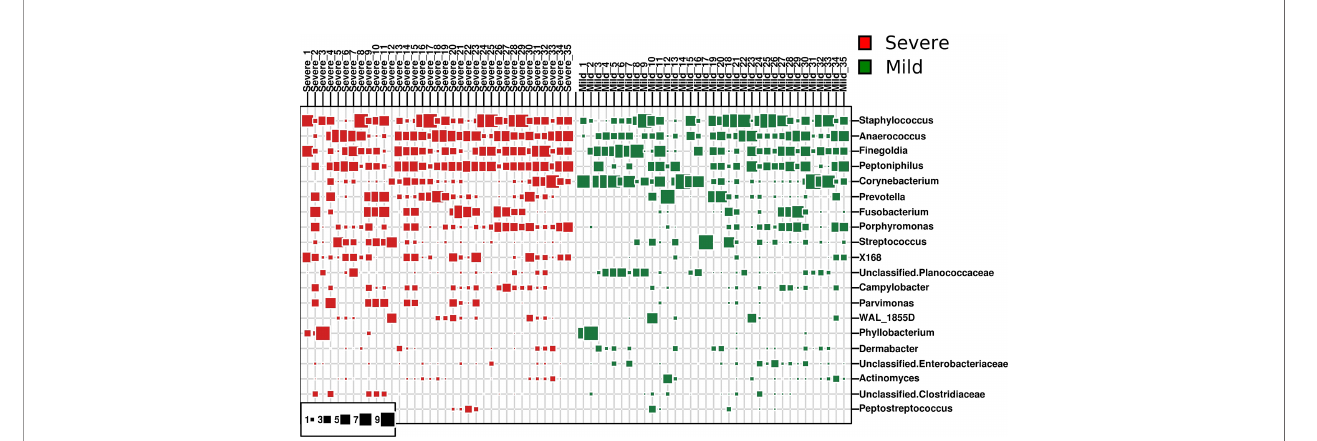
FIGURE 1 | Dominant bacterial genera in the dermis of patients with paronychia. The top 20 dominant bacterial genera in dermic tissue are shown in the bubble chart, patients with mild paronychia are in the green group, and patients with severe paronychia are in the red group. The genera were listed from the top to the bottom according to their relative abundance in the dermic tissue, and their RAs are shown in squares.